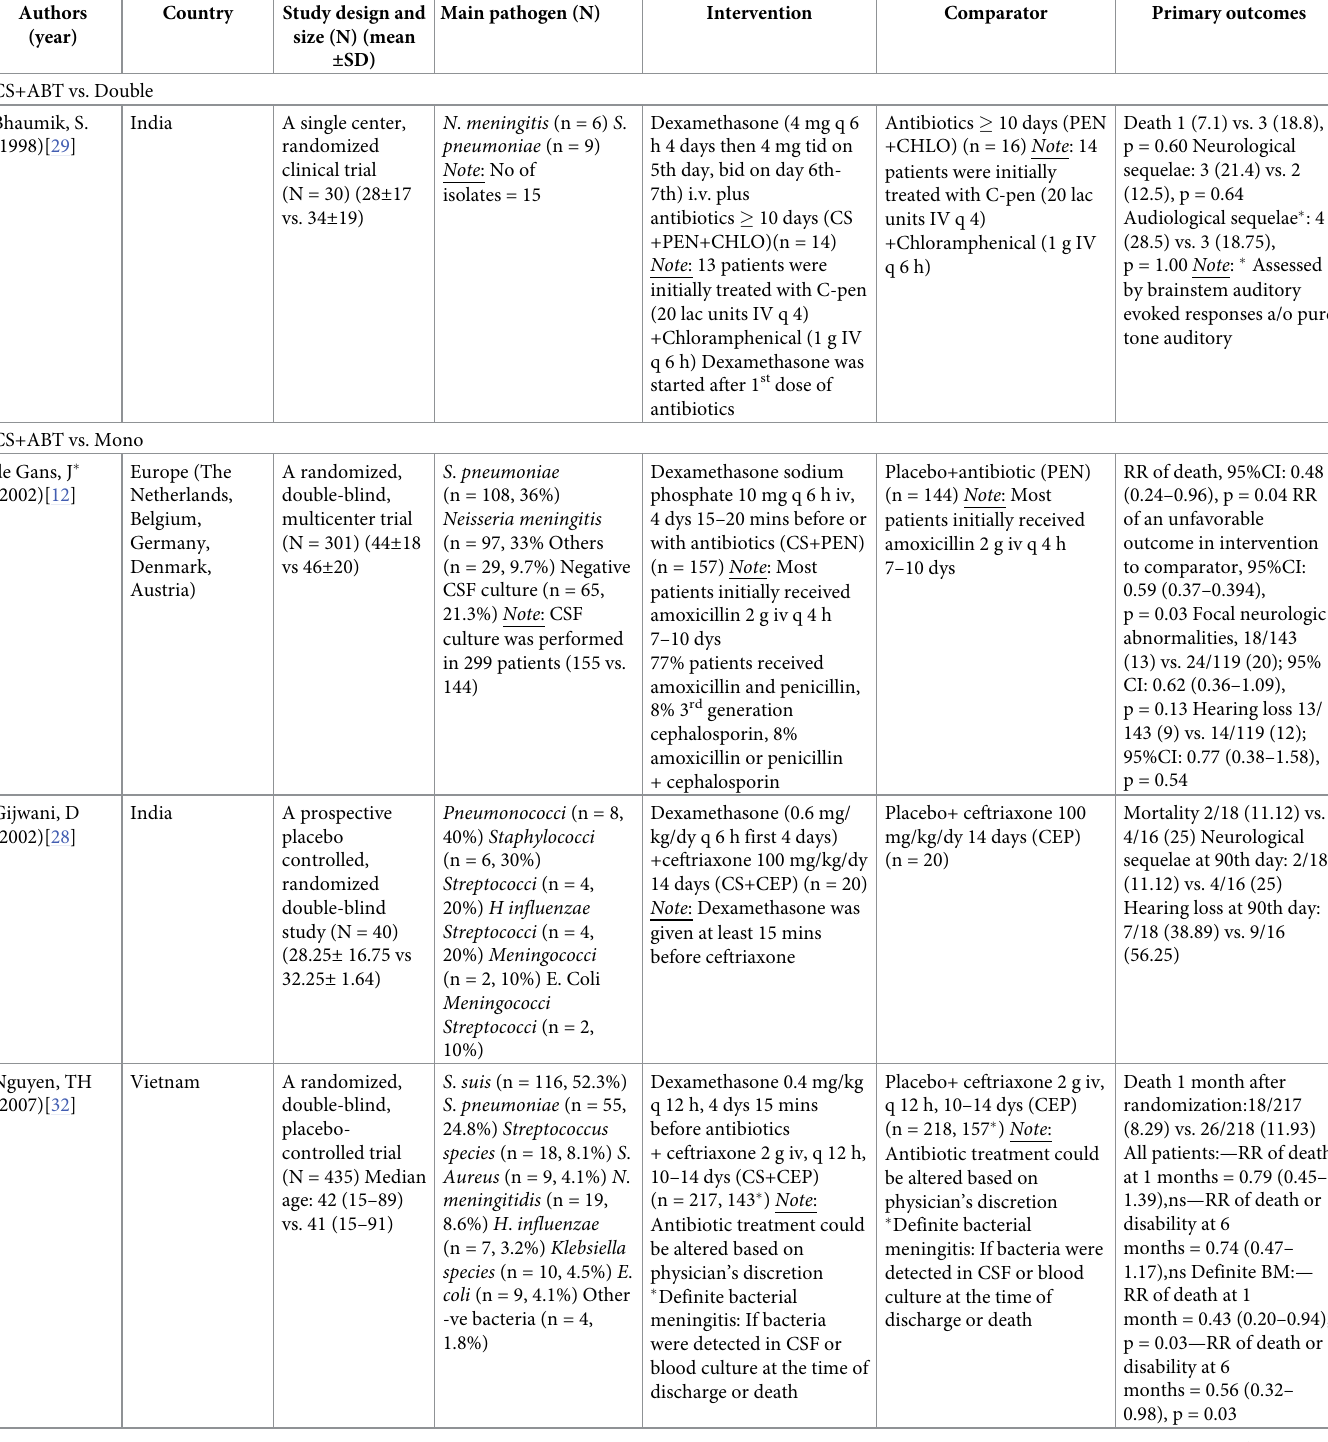
Table 1. Key characteristics of included